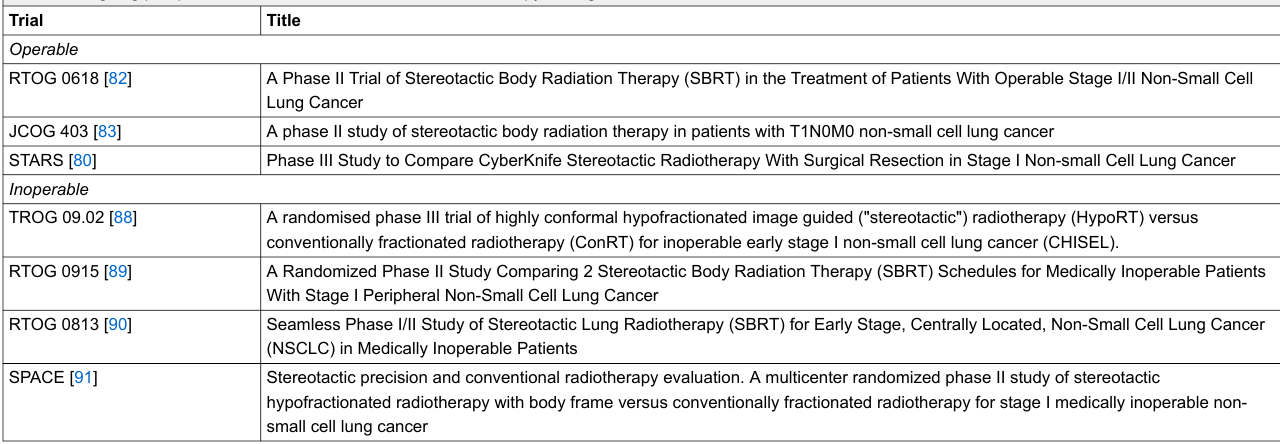
Table 3: Ongoing prospective trials of stereotactic ablative radiotherapy in lung cancer.